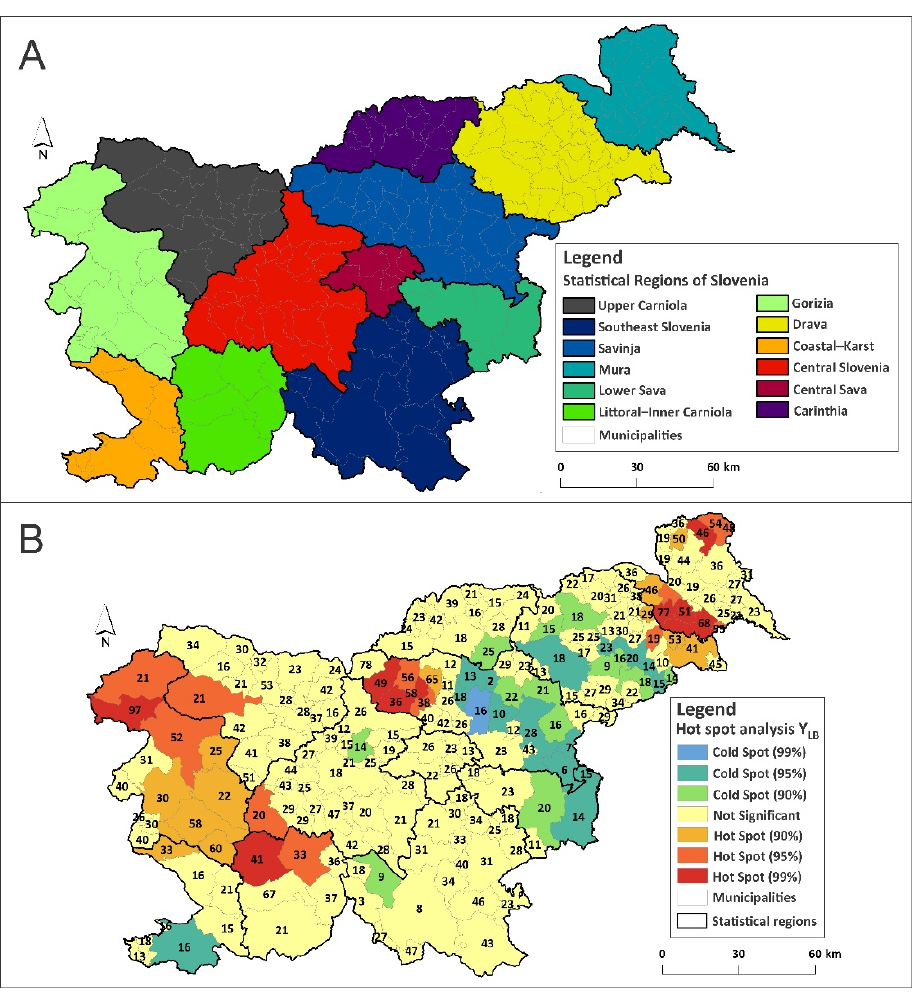
Figure 1. ( A ) Statistical regions of Slovenia (NUTS 3); ( B ) hot and cold spots for Y LB in Slovenia. The number represent actual Y LB values.